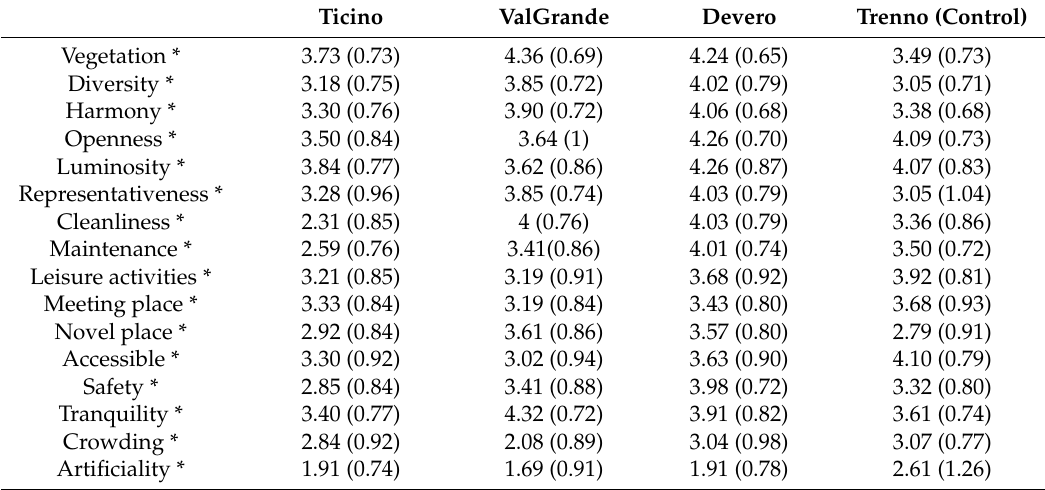
Table 3. Mean scores (plus standard deviations) for the sensorial, symbolic, and aesthetic attributes of each setting. * = significant statistical difference among the settings, p < 0.05.